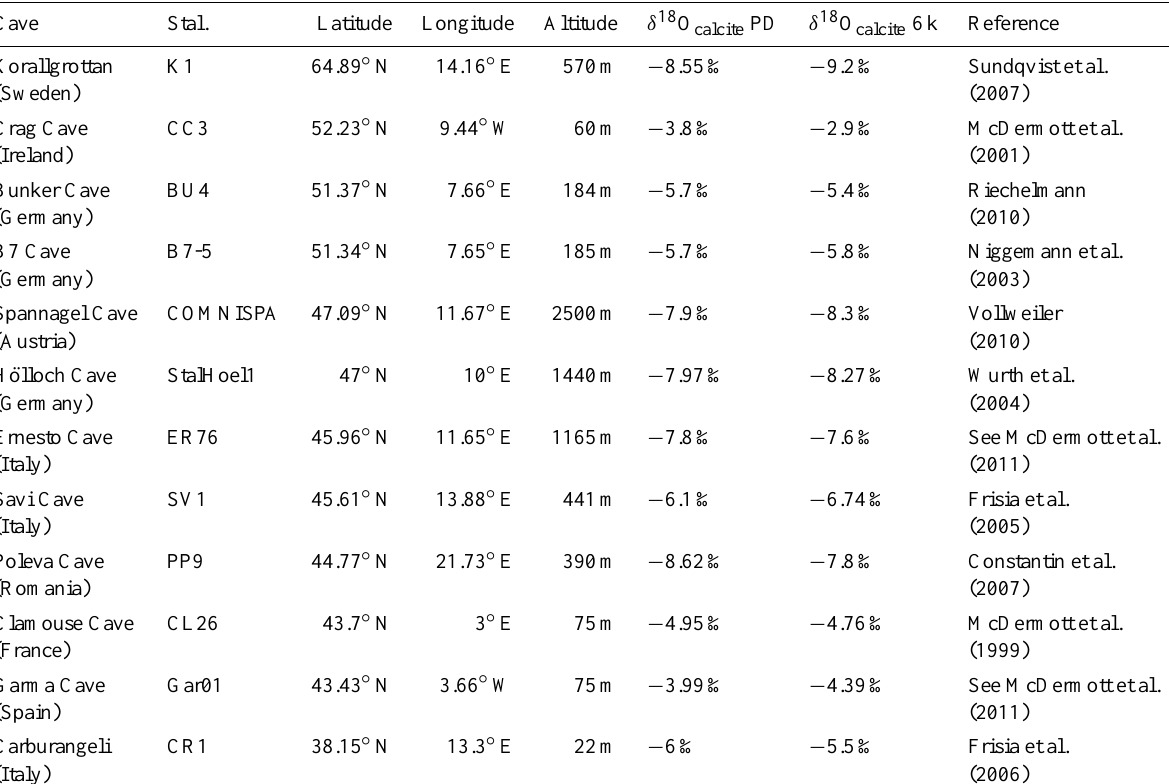
Table 3. Cave locations and compilation of isotope data of the studied 12 speleothems with mid-Holocene (6ka) δ 18 O calcite values, extracted from McDermott et al. (2011). Calcite δ 18 O values refer to